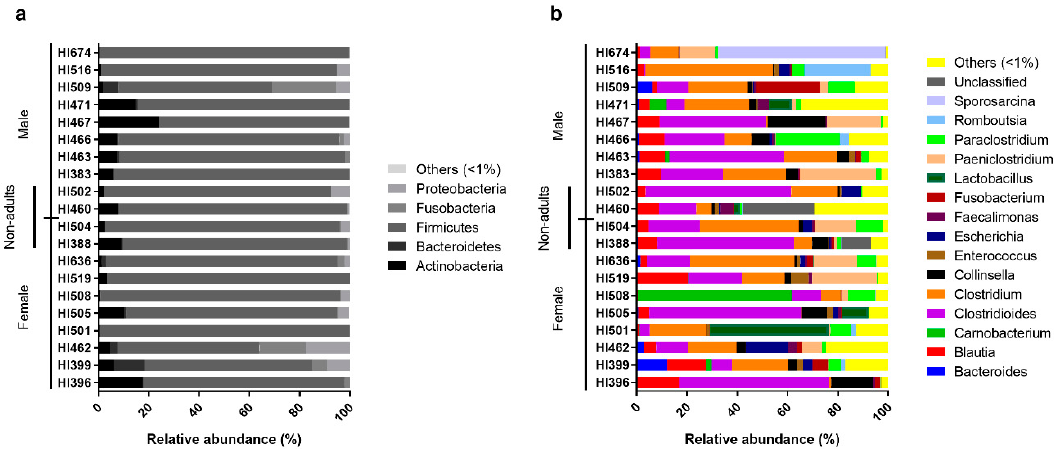
Figure 2. Relative abundance of the individual intestinal bacterial microbiota of the Egyptian mongoose on a phylum ( a ) and genus ( b ) level.